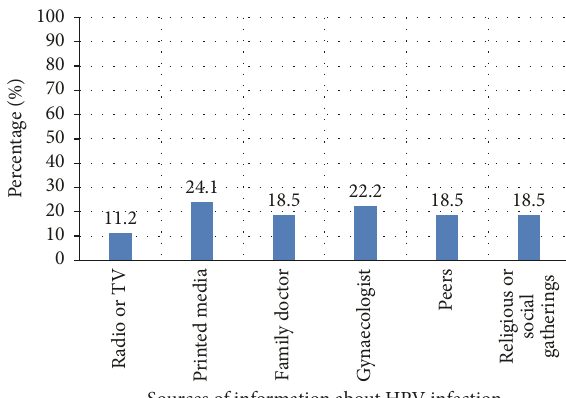
Figure 1: Reported sources of information among respondents with correct knowledge of HPV infection ( 𝑛 = 43 ) ( 𝑃 > 0.091